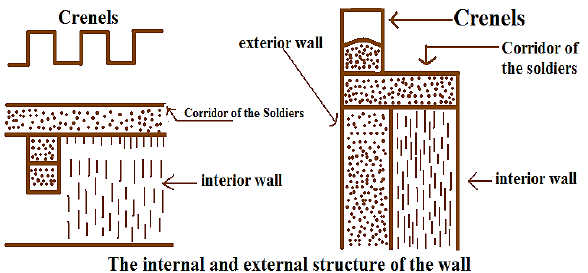
Figure 6. Longitudinal and cross-sectional design of the inner and outer structures of the kasbah walls.